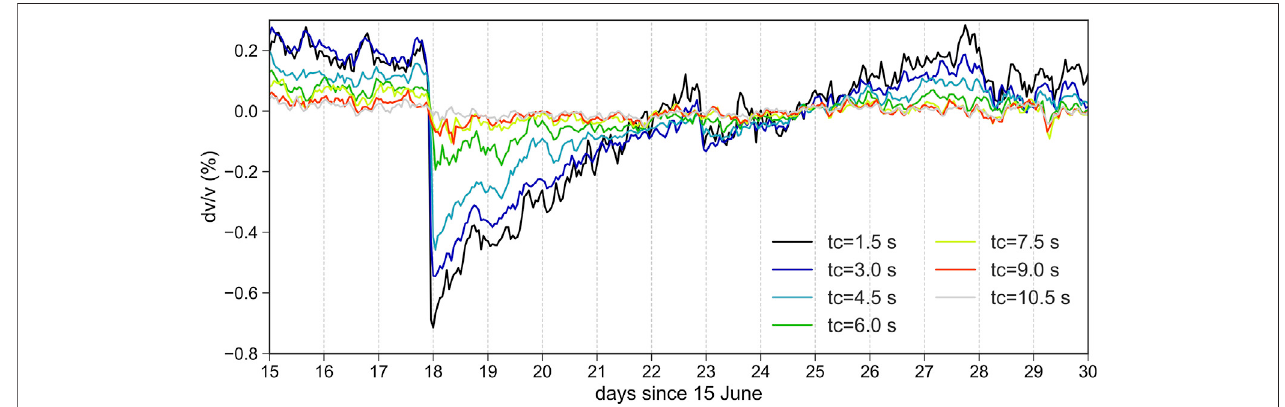
FIGURE 5 | Velocity changes with seven different time lapses of the coda.